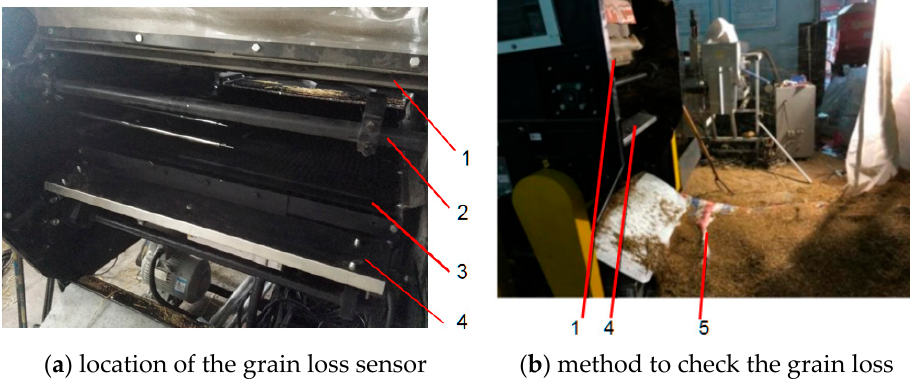
Figure 5. Experimental setup used to test the monitoring accuracy of the grain loss sensor. ( 1 ) Return plate; ( 2 ) drive mechanism for return plate; ( 3 ) tail sieve; ( 4 ) grain sieve loss sensor; ( 5 ) oil skin.